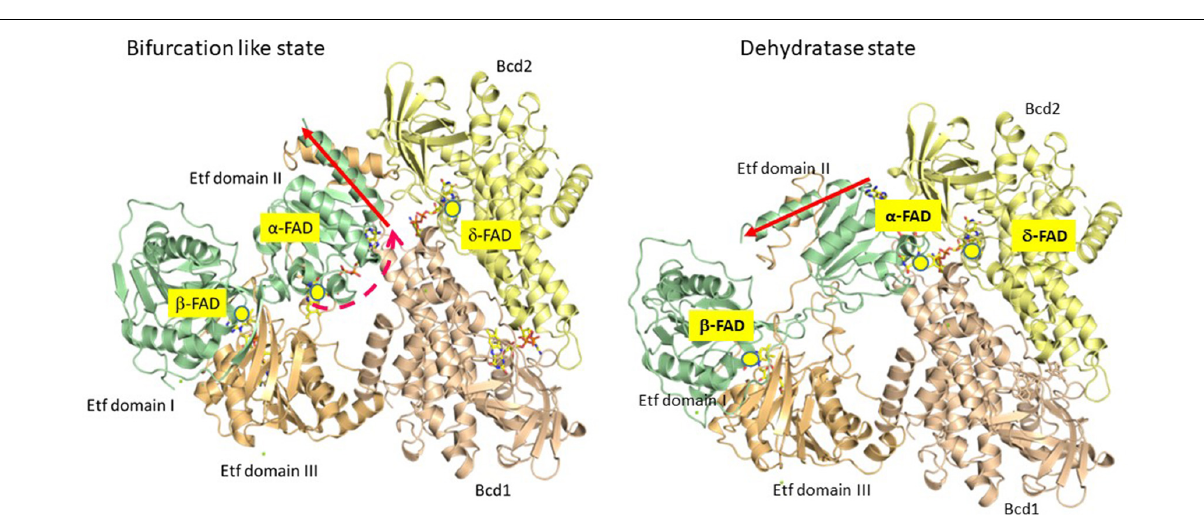
FIGURE 2 | Partial crystal structures of the recombinant Etf-Bcd complex from C. difficile produced in E. coli; EtfAB and 2 subunits of the tetrameric Bcd are displayed. The dehydratase state shows the structure as solved. In the bifurcation state domain II of Etf rotated CW by 80 ◦ as found in Etf from A. fermentans (see red arrow) ; Etf, domains I + II (subunit A) in green, domain III (subunit B) in light brown, Bcd1 in yellow and Bcd2 in pinkish-brown. In the dehydratase state, α -FAD and δ -FAD are located close together (8 Å distance), ready for ET. In the bifurcation-like state, α -FAD and β -FAD are 18 Å apart; further rotation by 10 ◦ CW